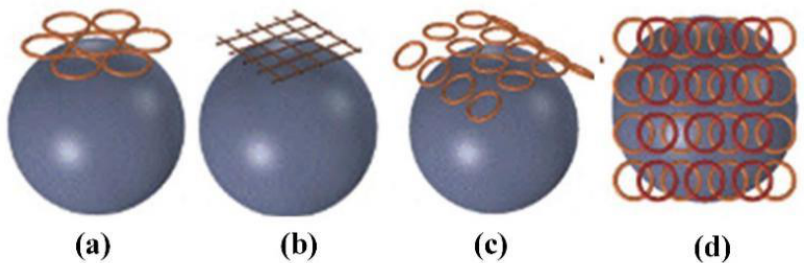
Figure 10. The structure of the TMS coil arrays. ( a ) Circular coil array. ( b ) Linear coil array. ( c ) Cap- formed coil array. ( d ) Multi-layer coil array.